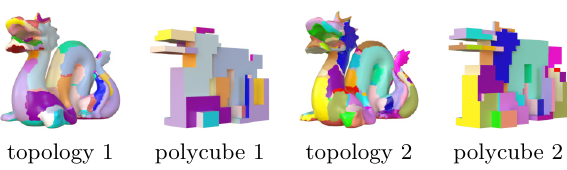
Fig. 2 A model with two different polycube topologies.